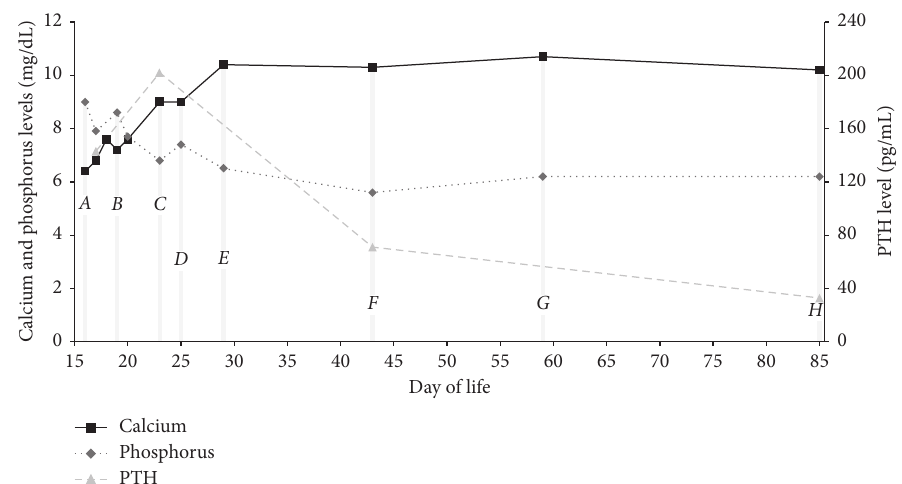
Figure 1: Initiated calcium carbonate at 100mg/kg/day and low-phosphate formula (A: day of life (DOL) 16) and cholecalciferol at 2000units/day (B: DOL 19). Weaned calcium carbonate to 75mg/kg/day (C: DOL 23), 56mg/kg/day (D: DOL 25), and 26 mg/kg/day (E: DOL 29). Transitioned to regular formula (F: DOL 43). Discontinued calcium carbonate (G: DOL 59). Weaned cholecalciferol to 400units/ day (H: DOL